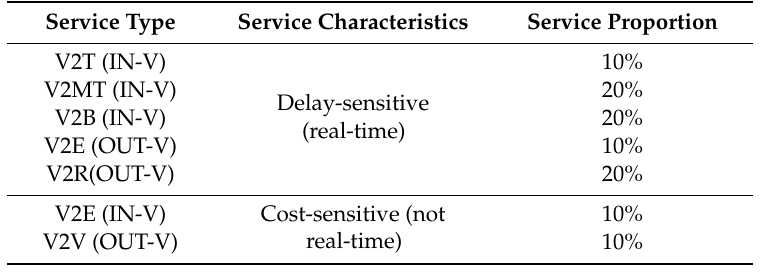
Table 2. Multi-service splitting parameters (1).